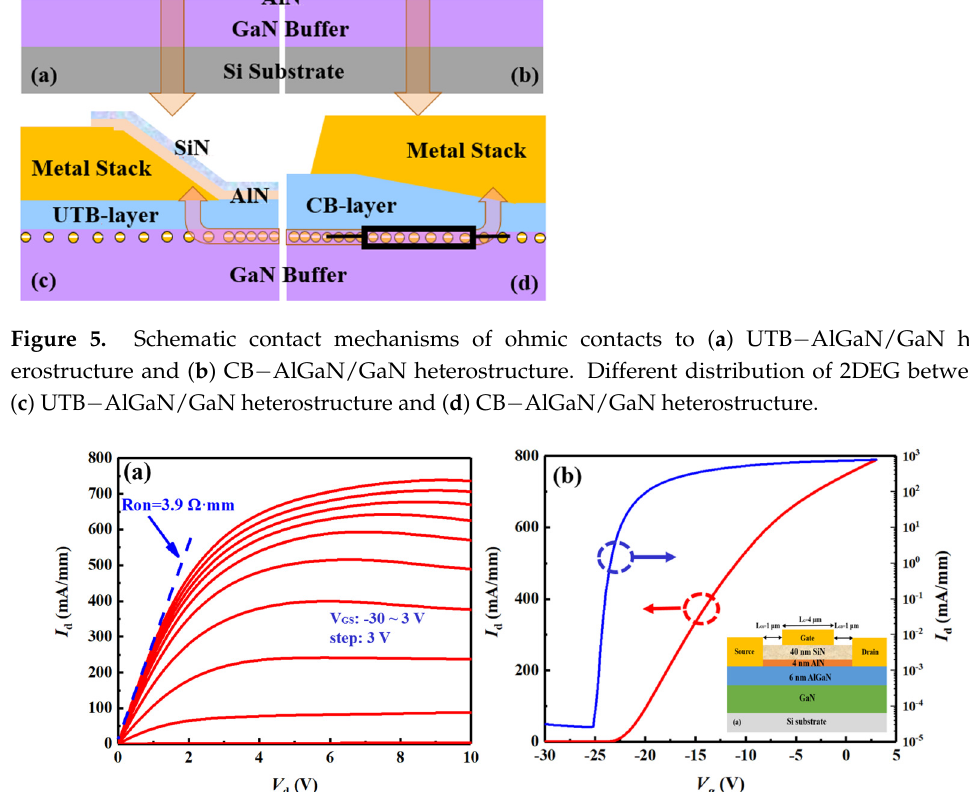
Figure 5. Schematic contact mechanisms of ohmic contacts to ( a ) UTB − AlGaN/GaN heterostructure and ( b ) CB − AlGaN/GaN heterostructure. Di ff erent distribution of 2DEG between ( c ) UTB − Al- GaN/GaN heterostructure and ( d ) CB − AlGaN/GaN heterostructure.